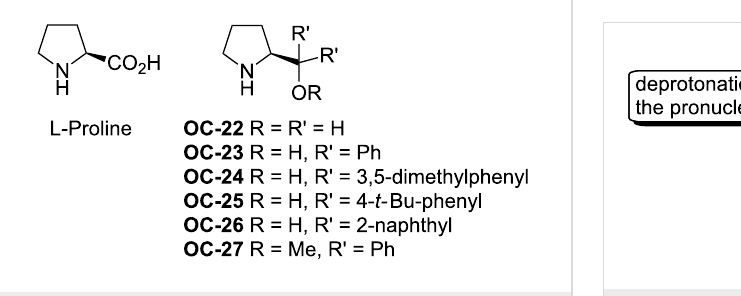
Figure 6: L -Proline and its derivatives OC-22 to OC-27 . Figure 7: Proposed bifunctional mode of action of OC-23